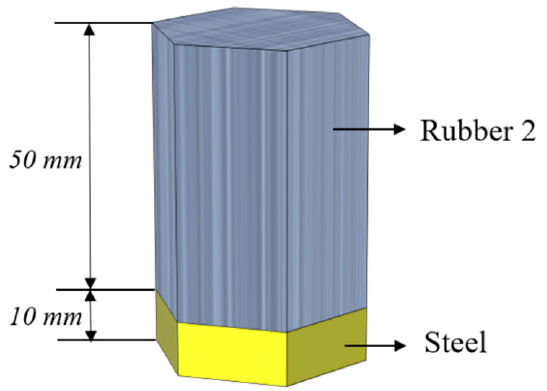
Figure 3. Finite element method (the verification model).